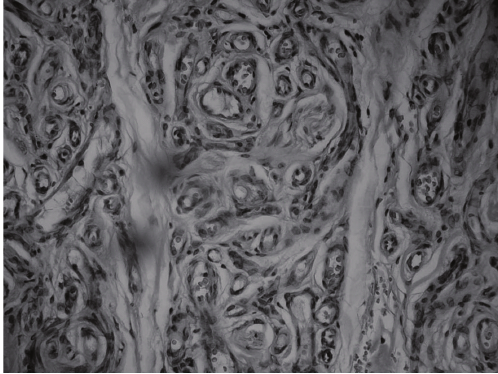
Figure 2: Proliferation of capillaries (400x, HE).